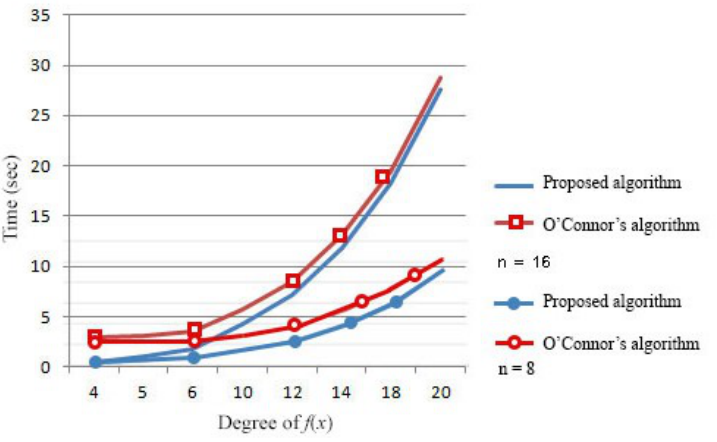
Figure 4. Execution time in GF ( 2 8 ) and GF ( 2 16 )